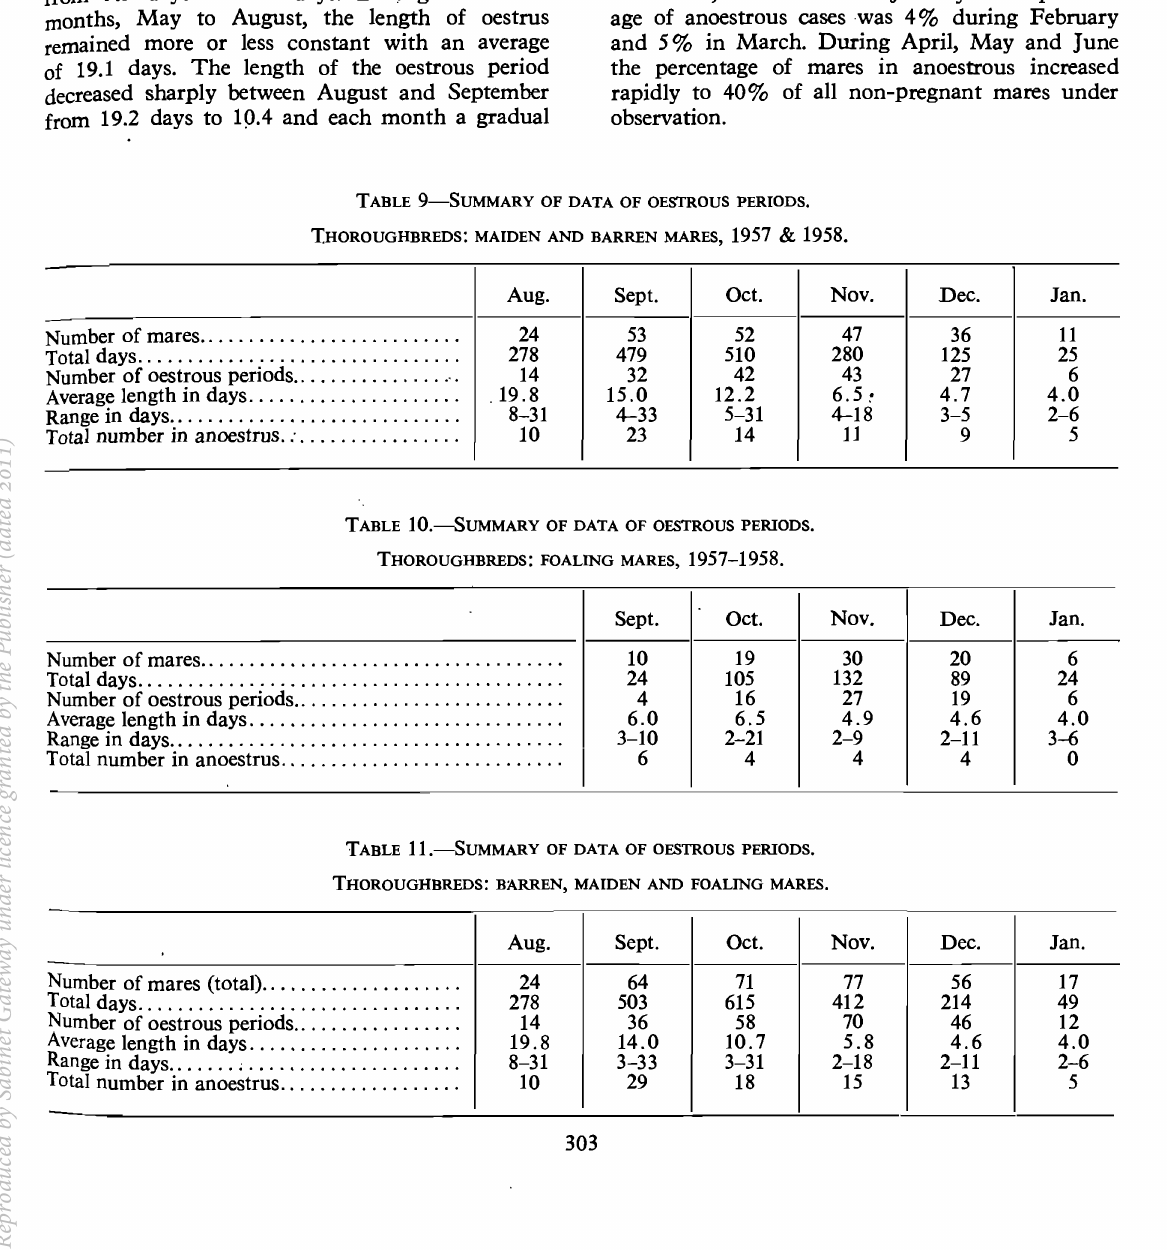
TABLE 9-SUMMARY OF DATA OF OESTROUS PERIODS. THOROUGHBREDS: MAIDEN AND BARREN MARES, 1957 & 1958.